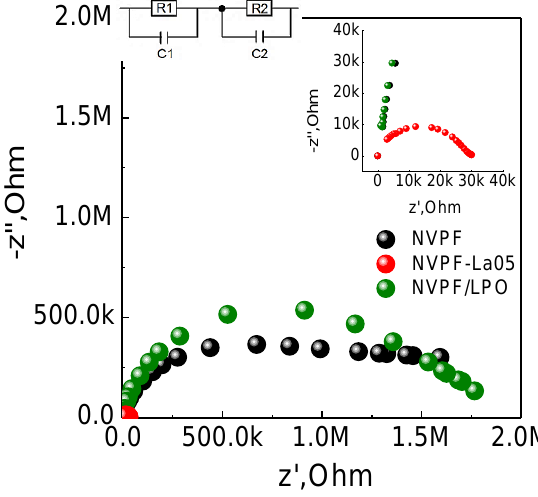
Figure 5. Electrochemical impedance spectra of NVPF, NVPF-La05 and NVPF/LPO.